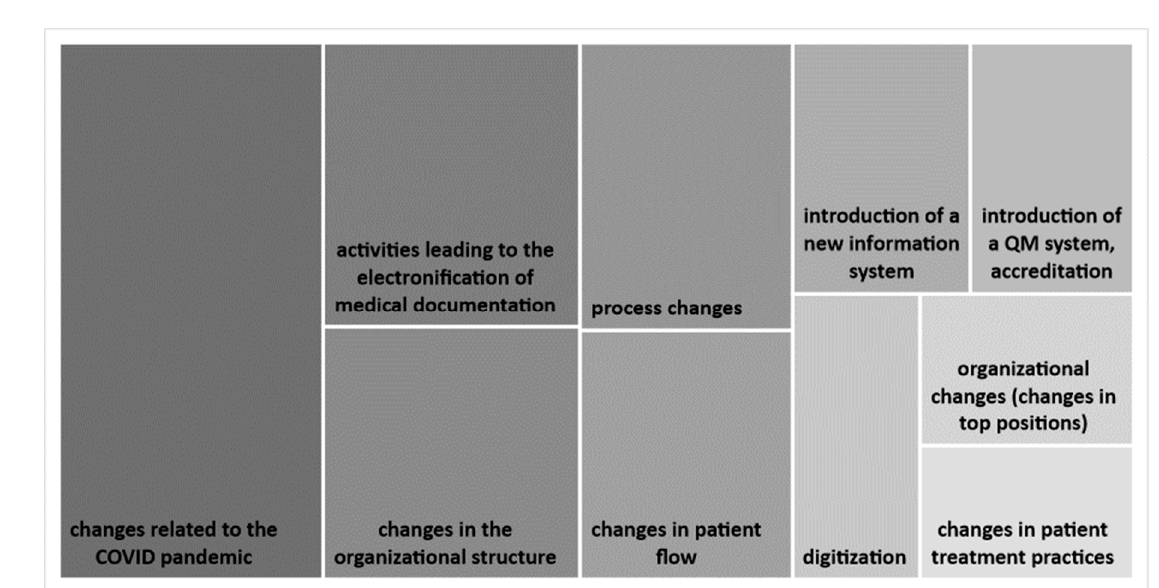
Figure 3. The Top 10 most common changes taking place in hospitals.